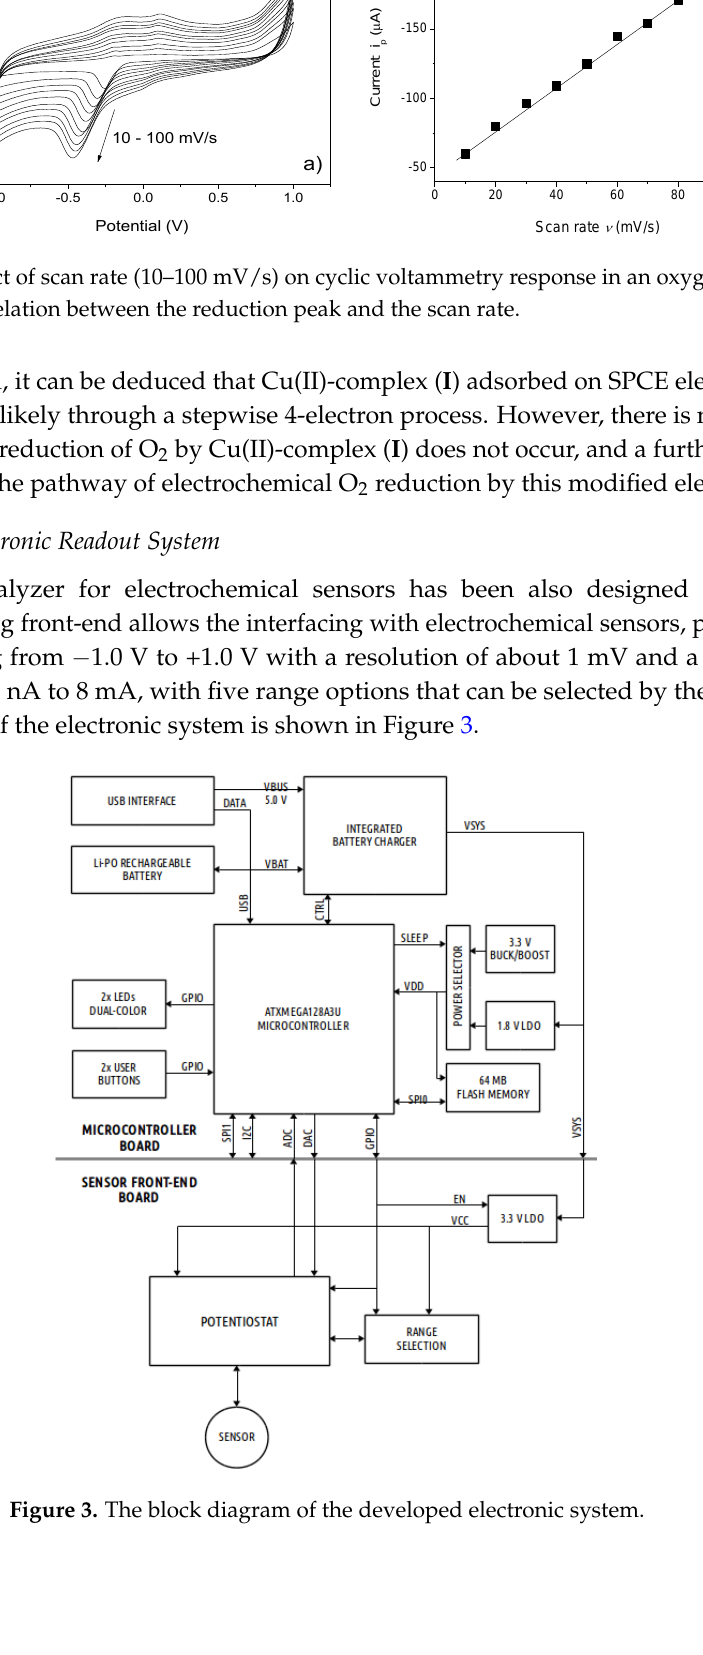
Figure 3. The block diagram of the developed electronic system.